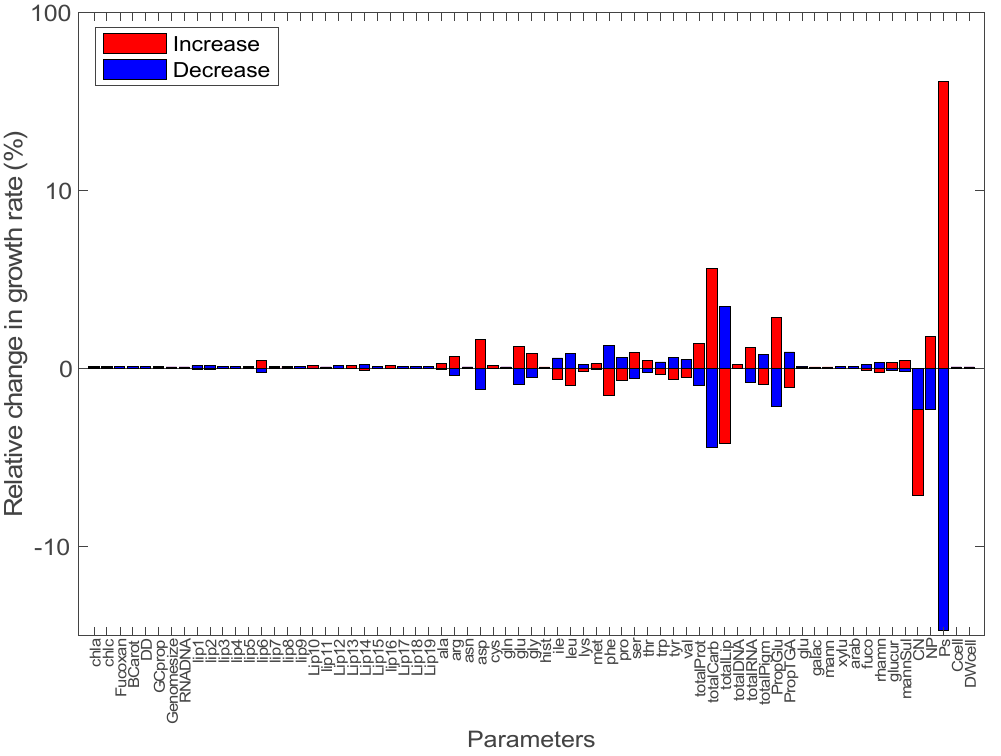
Figure 1. Local sensitivity analysis of the model output (growth rate) to an increase (red bars) or decrease (blue bars) by an arbitrary factor of 40% for each of the 69 model parameters taken independently. The percentage of variation of the growth rate is given on the y-axis (on a log scale) as a function of changes in parameter values (see Table 1 and Section SI.1 for details and units of parameters). (1) chla: chlorophyll a; (2) chlc: chlorophyll c; (3) Fucoxan: fucoxanthin; (4) BCarot: beta-